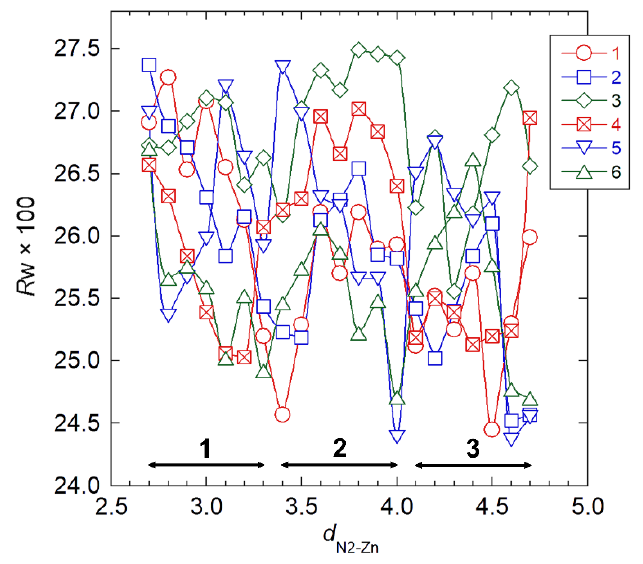
Figure 3. R w with the respect to N2–Zn distance, d N2–Zn , in structure refinement for six ZnCl 2 linking patterns. Double-headed arrows indicate d N2–Zn ranges where we obtained the models by the preceding three-dimensional structure refinement. Numbers 1–6 refer to corresponding model numbers.